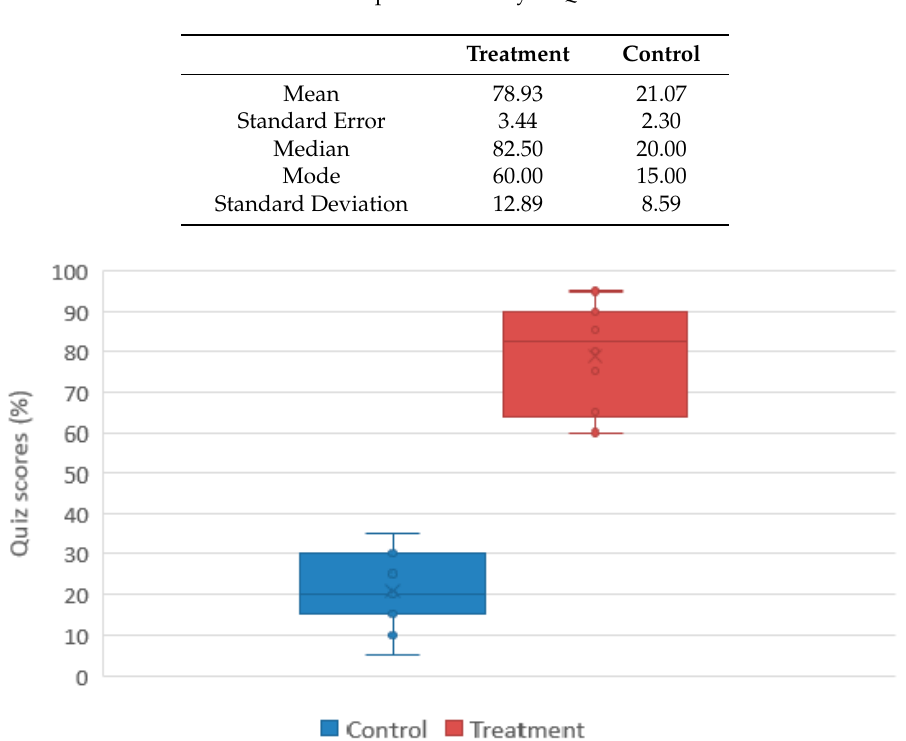
Figure 4. Box plot quiz scores for the treatment and control groups.